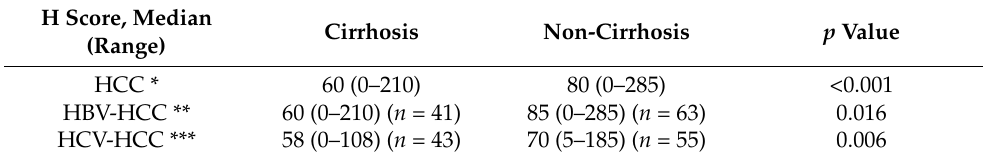
Table 5. Tid1 expression in non-tumor liver tissue of cirrhotic and non-cirrhotic status of HCC. H Score, Median (Range)